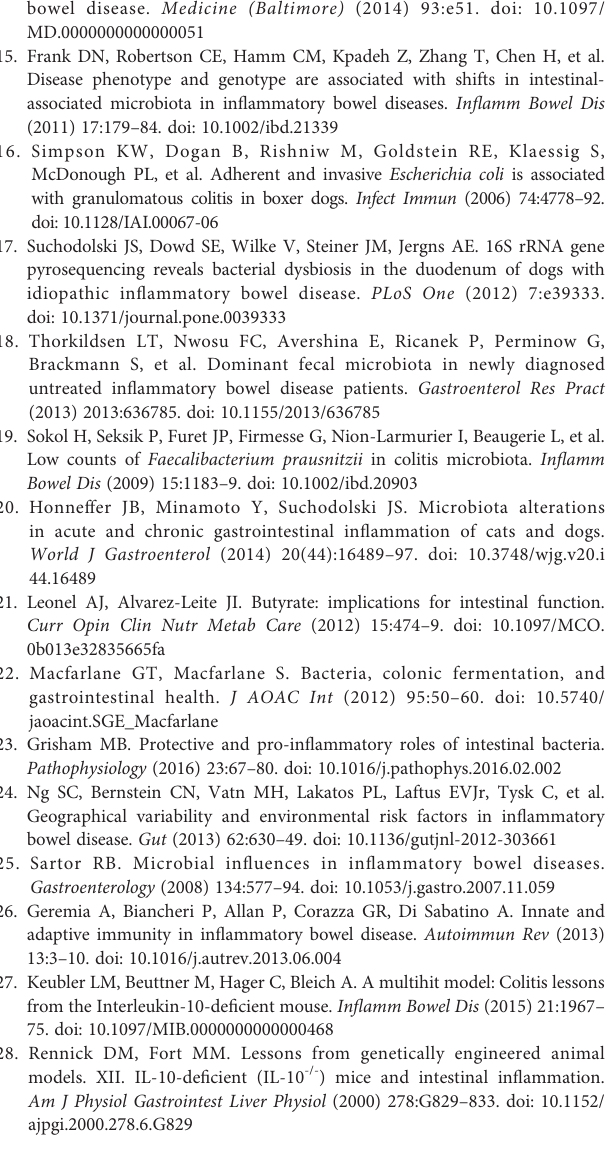
Supplementary Figure 1 | Taxonomic composition of the cecal microbiota at the phylum level. (A) Phylum level composition of WT and IL-10 -/- mice, as indicated, throughout the study. (B) Speci fi c phyla with statistically signi fi cant changes in abundance over the course of the study from WT and IL-10 -/- mice. The relative abundance (%) for each group is shown and p-values are shown parenthetically. The number of mice used for each strain at each time point varied as follows: at 4 weeks of age, n = 5; at 7 weeks of age, n = 10; at 10 weeks of age, n = 9; at 12 weeks of age, n = 13; at 19 weeks of age, n = 5. Supplementary Figure 2 | Taxonomic composition of the cecal microbiota at the genus level. (A) Genus level composition of WT and IL-10 -/- mice cecal microbiome